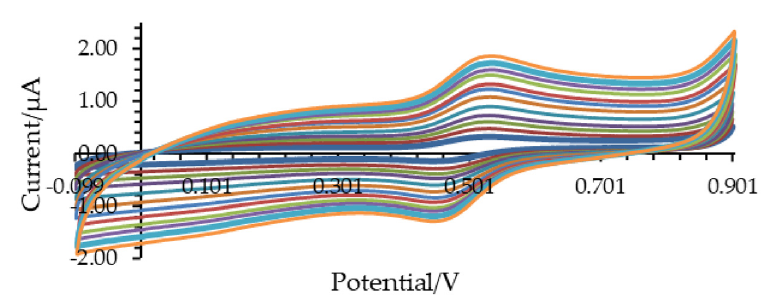
Figure 3. Cyclic voltammograms (electric current versus potential) of ABTS recorded at potential scan rate increasing from 5 to 100 mV/s. The other experimental conditions were the same as in Figure 4.